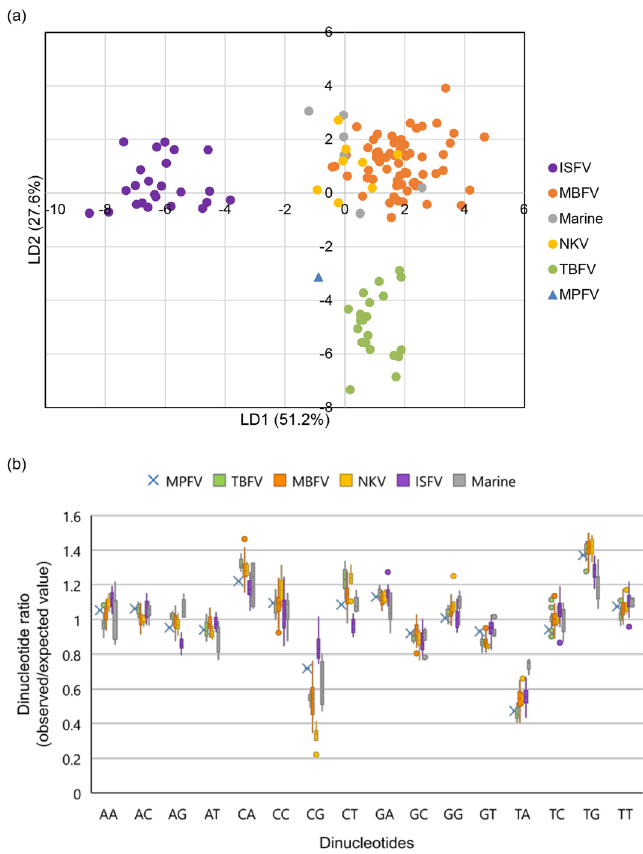
Figure 4. Nucleotide composition analysis of flaviviruses. ( a ) Score plot of the linear discriminant analysis (LDA). The figure shows a scatterplot of the two discriminant scores explaining the largest amount of the components from LDA (51.2% and 27.6% for LD1 and LD2, respectively). ( b ) Boxplot of dinucleotide ratios in flavivirus groups. Blue triangle ( a ) and blue cross ( b ) represent MPFV. Green: TBFV, orange: MBFV, yellow: NKV, purple: ISFV, gray: